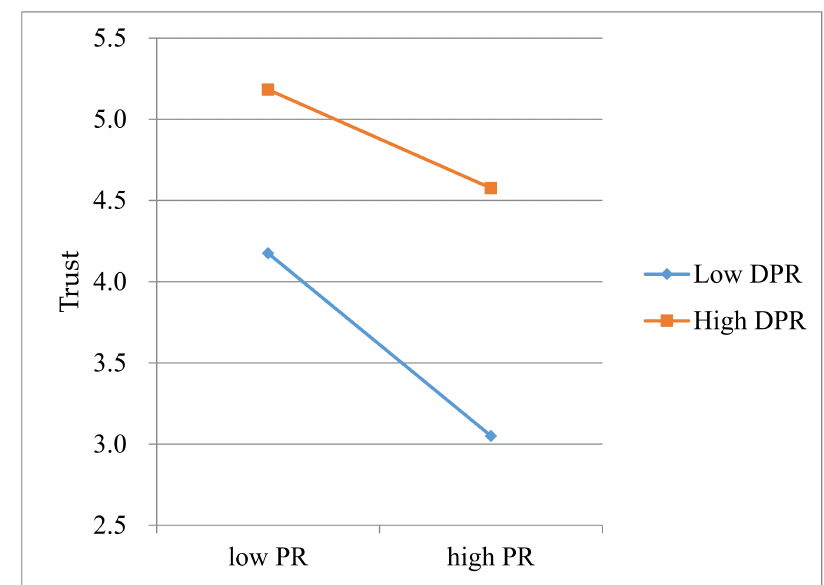
Figure 3. Interactive effects of PR and DPR on